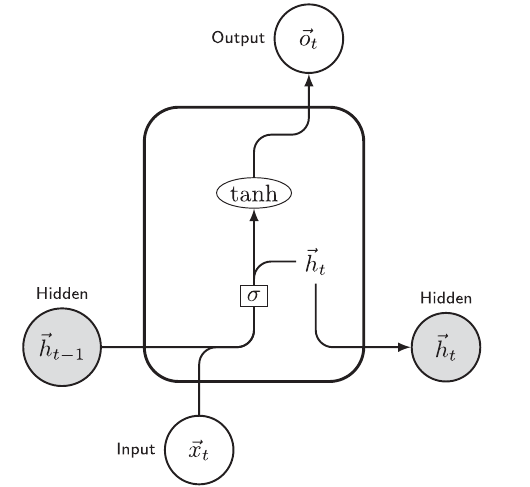
FIG. 3. The structure and updating scheme of an ERNN cell.